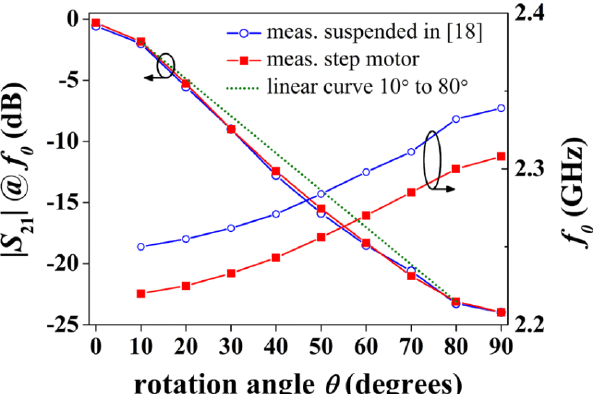
Figure 14. Transmission coefficient at f 0 as a function of the rotation angle. From [22], reprinted with permission.